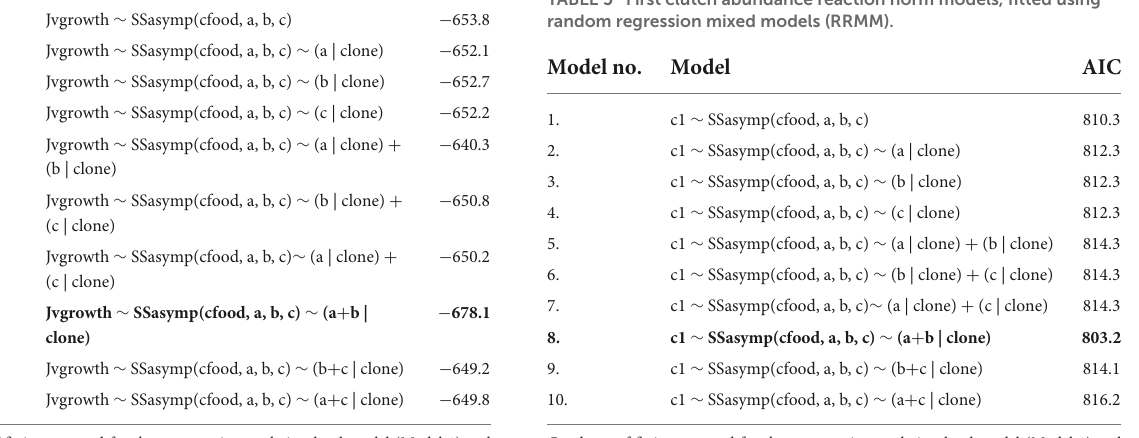
Goodness of fit is compared for the asymptotic population-level model (Model 1) and mixed models with varying combinations of the clonally-variable model